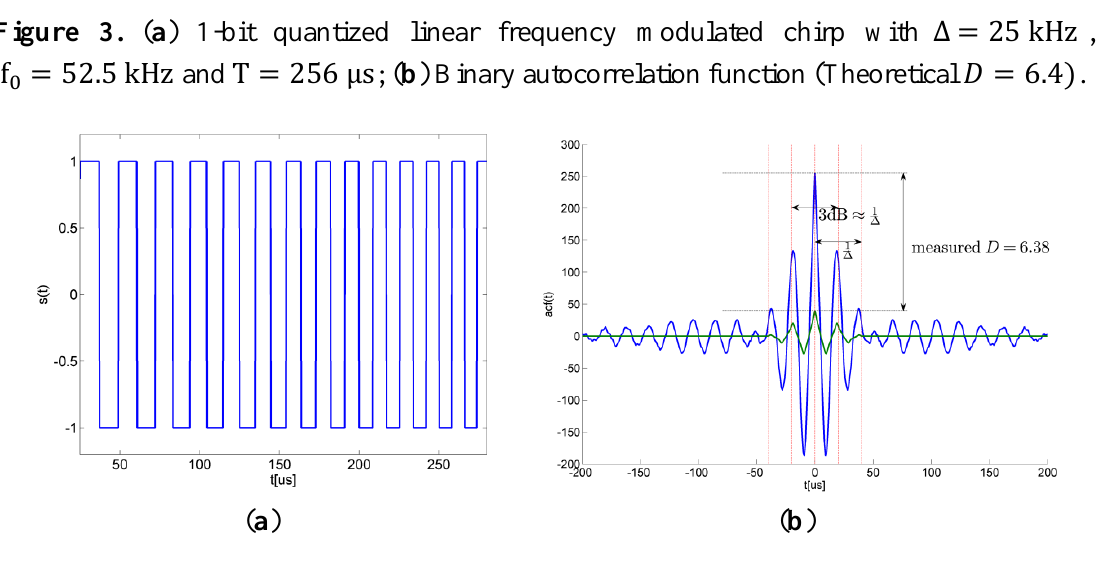
Figure 4. ( a ) Directivity diagram without attached cone of Senscomp 600 electrostatic transducer; ( b ) Directivity diagram after application of